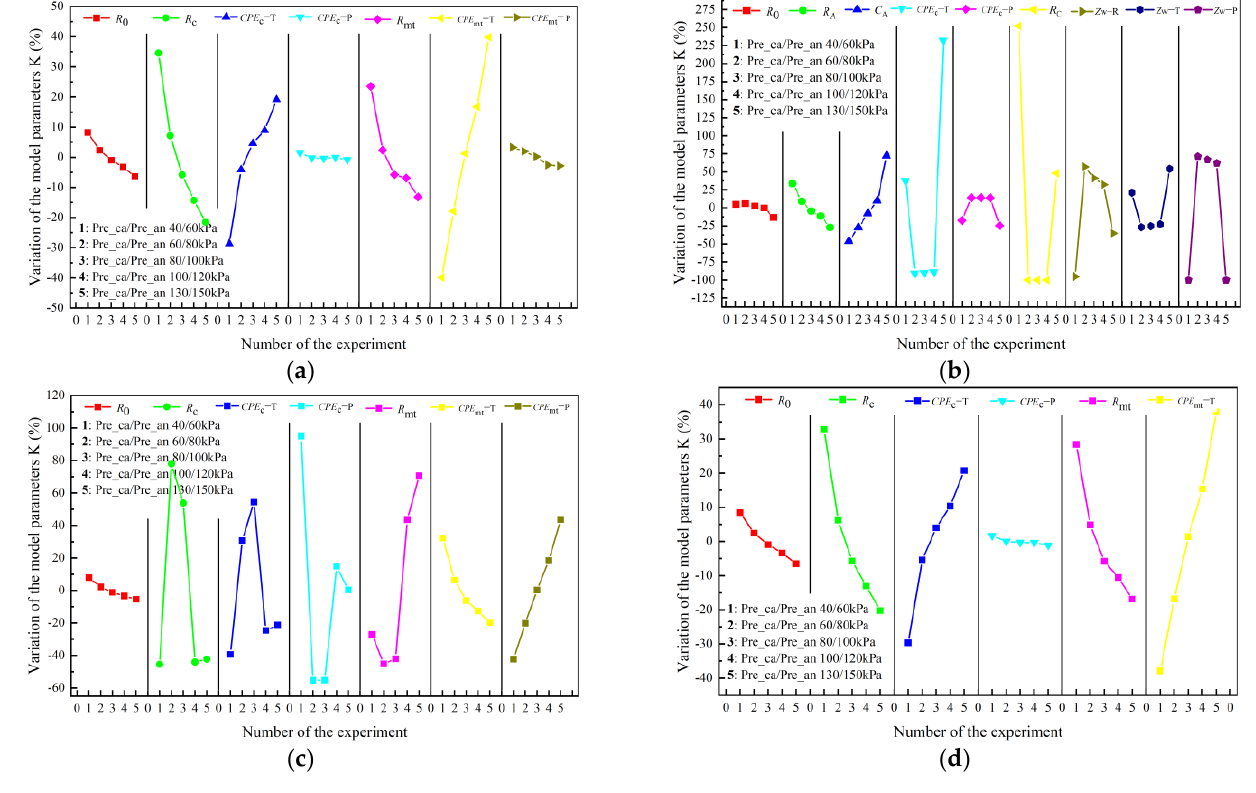
Figure 7. The Changing trend of the model parameters under different inlet pressure: ( a ) the parameter variations of model A; ( b ) the parameter variations of model B; ( c ) the parameter variations of model C; ( d ) the parameter variations of model D.